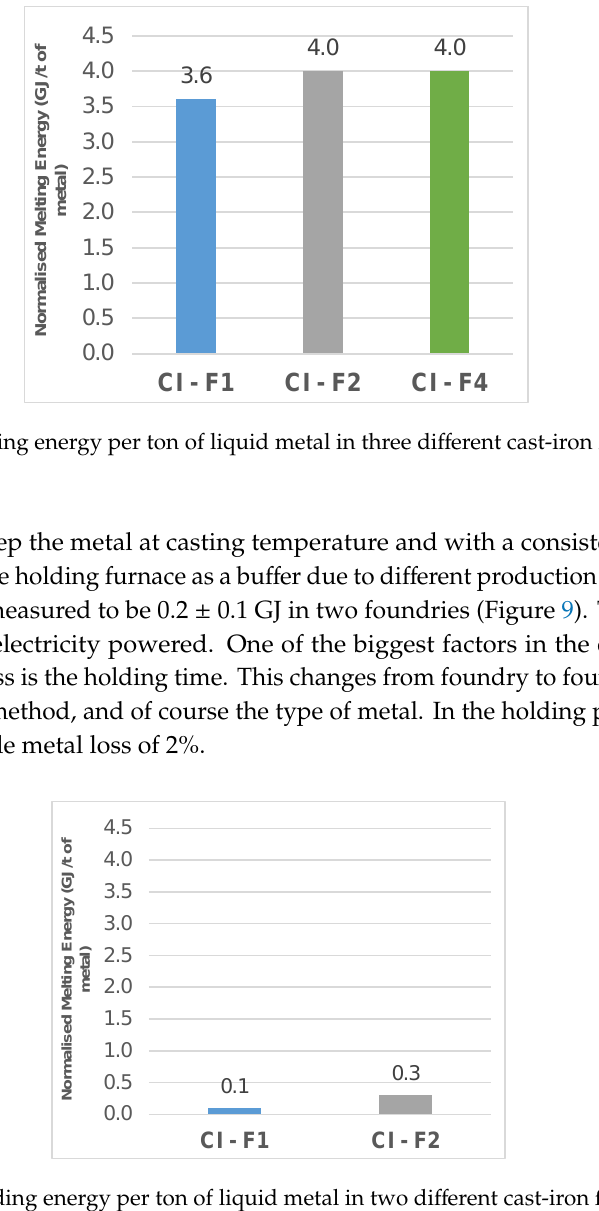
Figure 9. Holding energy per ton of liquid metal in two different cast-iron foundries.